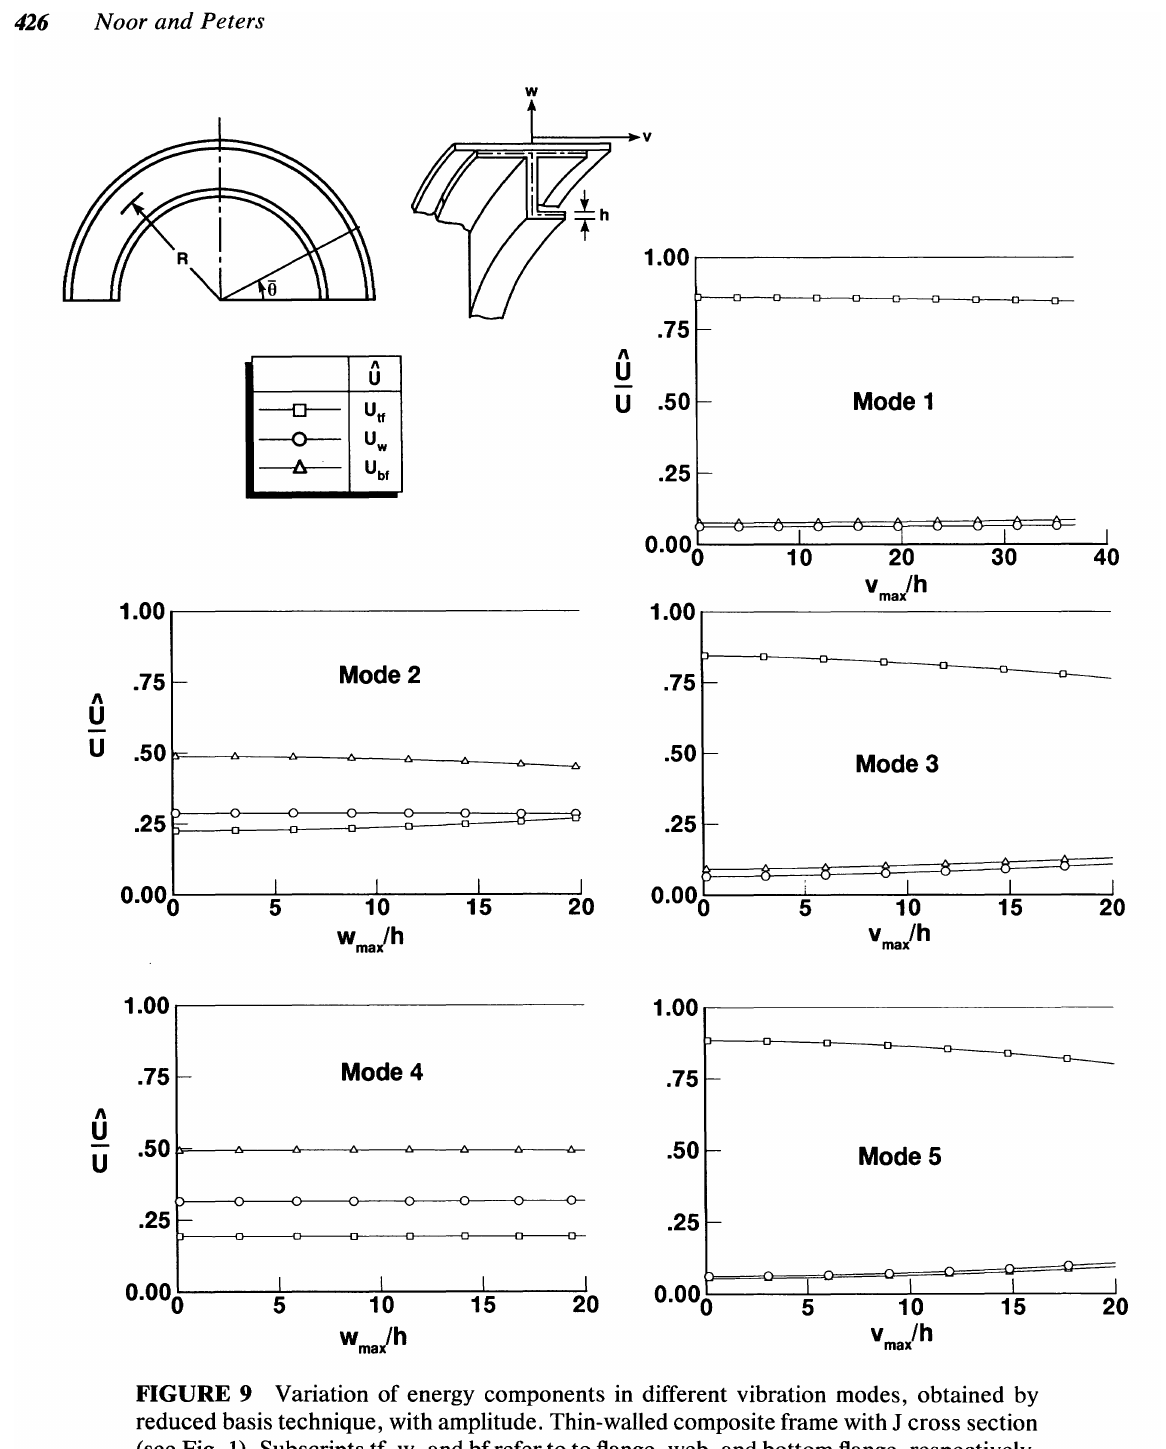
FIGURE 9 Variation of energy components in different vibration modes, obtained by reduced basis technique, with amplitude. Thin-walled composite frame with J cross section (see Fig. 1). Subscripts tf, w, and bfrefer to to flange, web, and bottom flange,